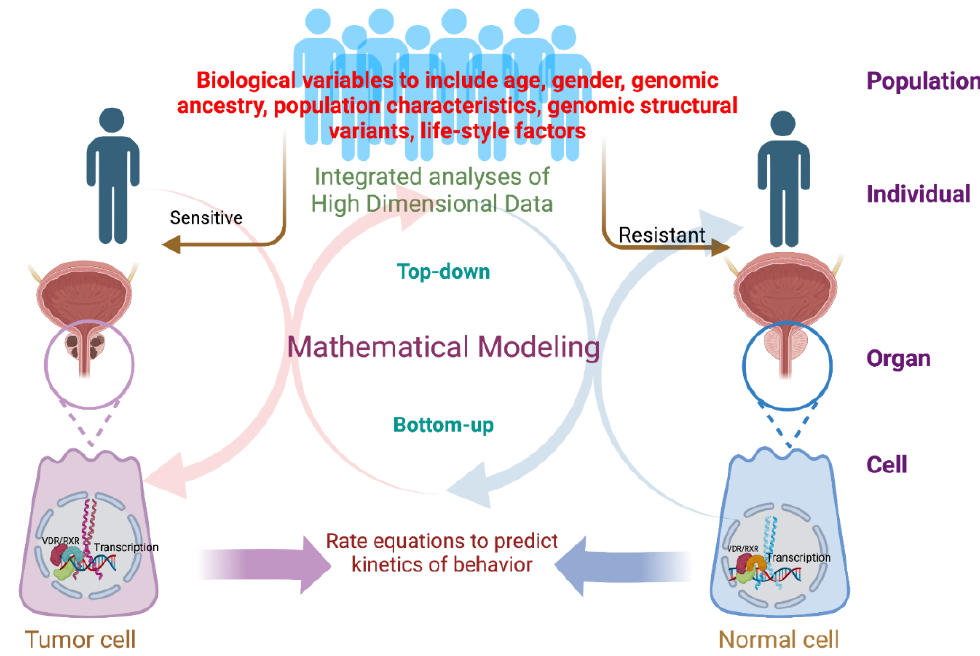
Figure 1. A workflow for top-down and bottoms-up system biology (SB) approaches to address prostate cancer health disparities. For top-down SB there is a plethora of high dimensional data including germline structural variants, population characteristics as serum-borne, and other clinical data that can be integrated through a range of approaches to deliver insights into how the prostate could either be either sensitive or resistant to the growth restraint properties of the VDR. From the bottoms-up perspective, more focused kinetic models can be developed for how the VDR functions and is disrupted between normal and tumor cells. Combining these approaches has the potential to develop a holistic understanding of how the VDR functions in the prostate gland and how this is impacted by genomic